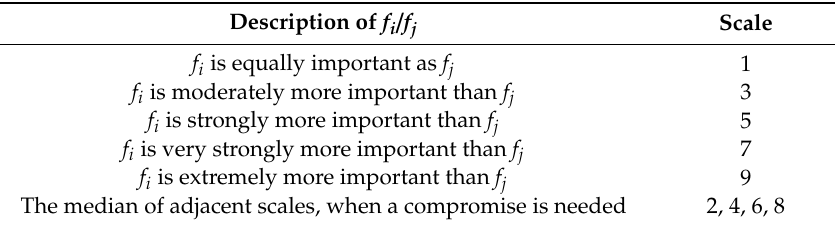
Figure 4. The proposed analytical hierarchy process model. Table 7. Value meaning of the nine-scale